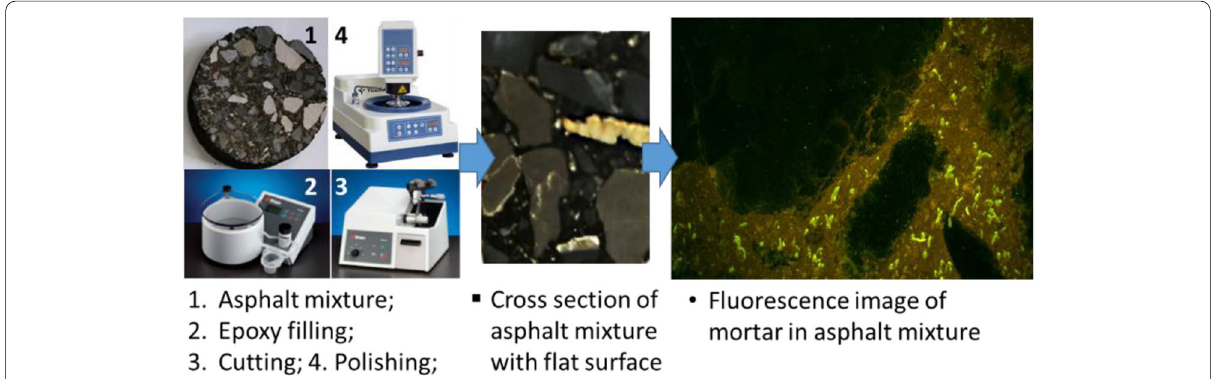
Fig. 2 Thin section preparation of asphalt mixture for fluorescence microscopic